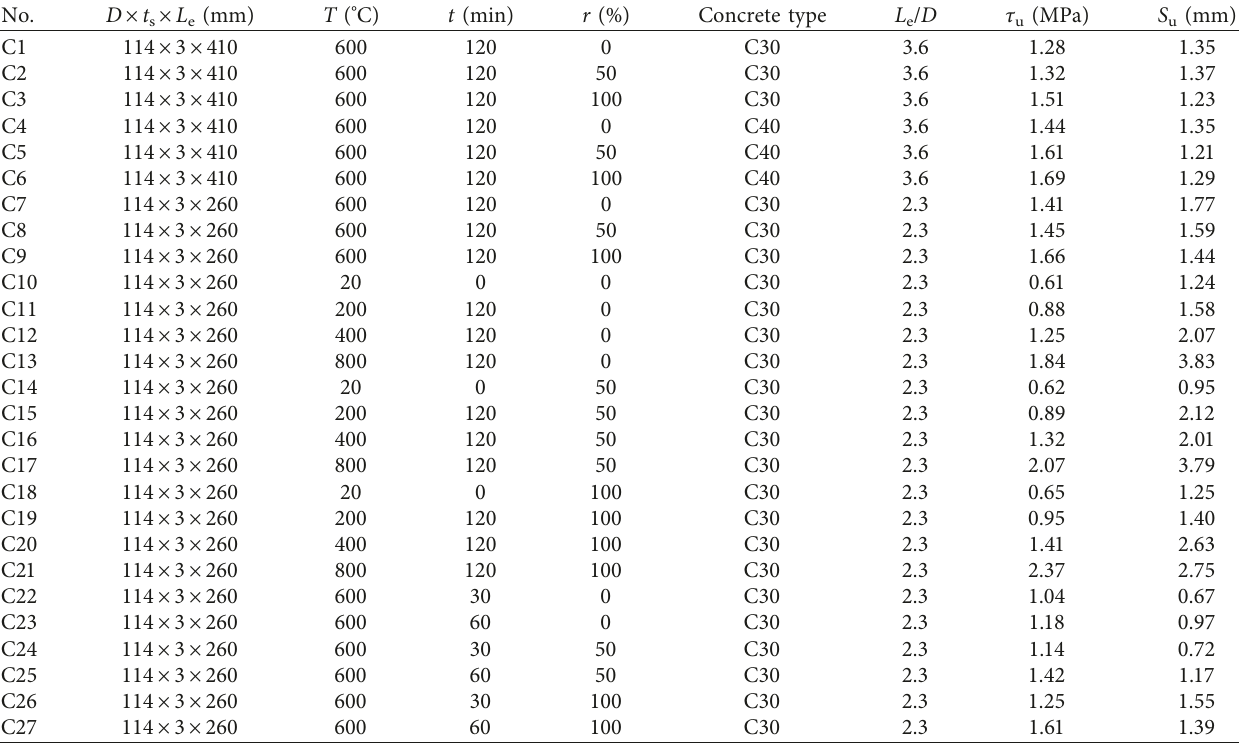
Table 1: Summary of test specimens and